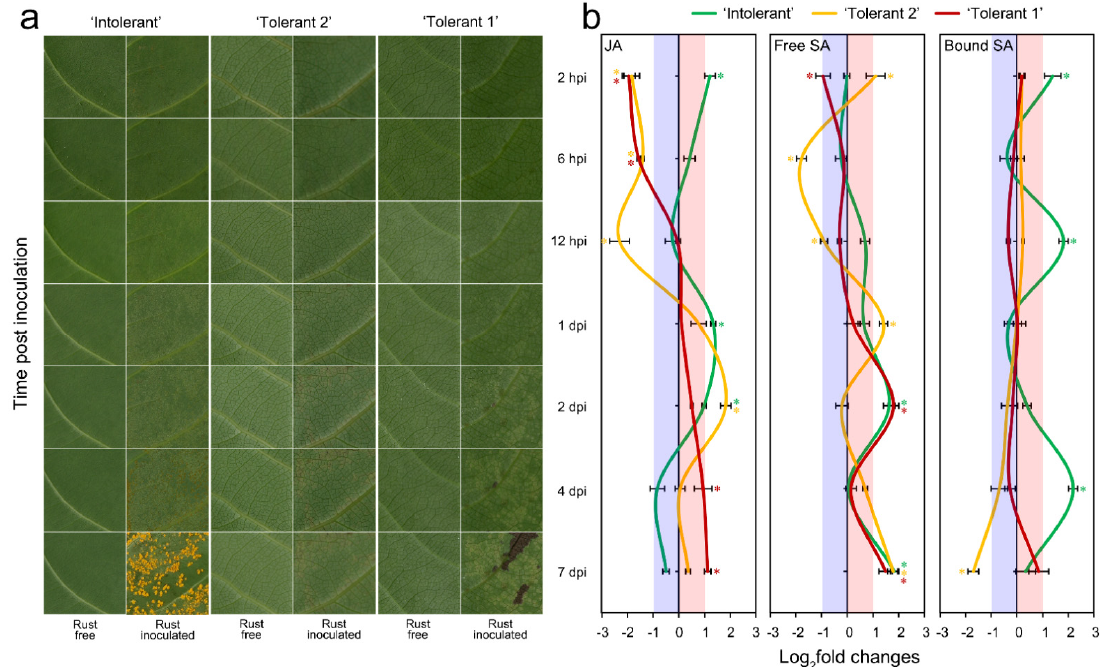
Figure 1. Symptoms and changes in JA and SA contents in poplar leaves infected with E4. ( a ) Symptoms of poplar leaves infected with E4. ( b ) Changes in JA and SA contents in poplar leaves infected with E4. * p -value < 0.01, rust inoculated leaves versus rust free leaves, n = 3; Hpi, hours post inoculation; dpi, days post inoculation.